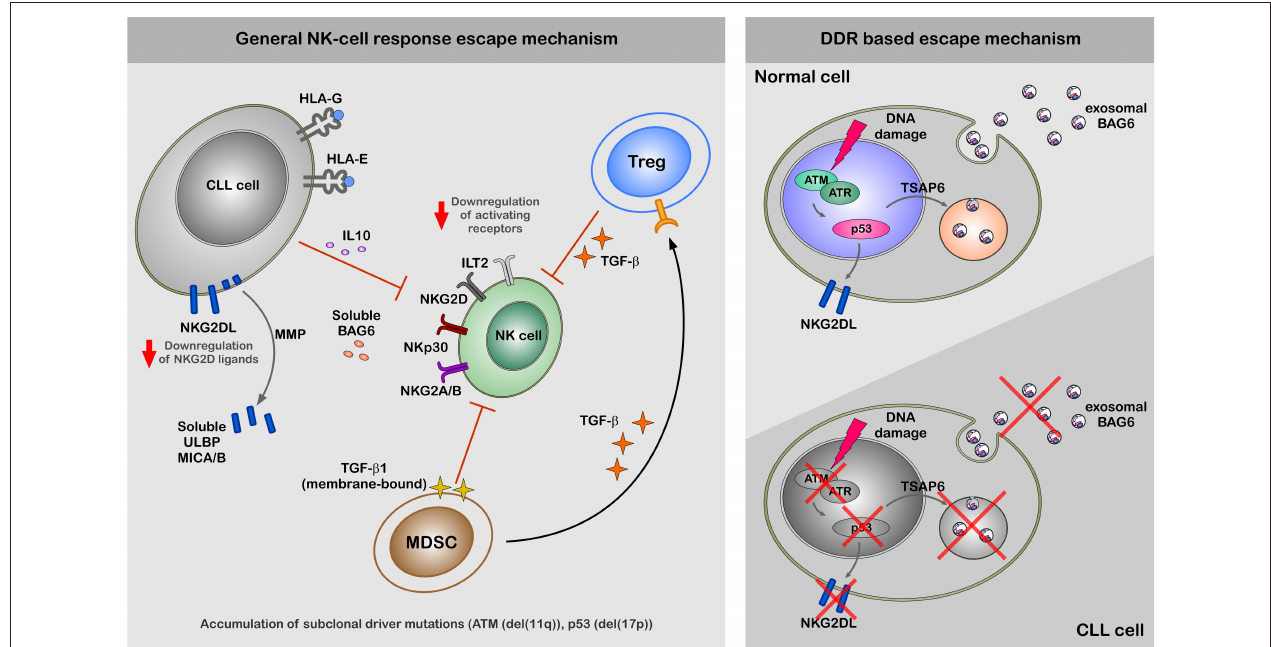
regulated by MDSC and Treg cells via production of TGF β and IL-10, which modulate expression levels of activating receptors on the cell surface of NK cells. The right panel of the figure is focused on the impaired DDR and its role for the escape from NK-cell response. Induction of DDR in healthy cells results in activation ATM-p53 axis. Activation of p53 results in cell surface expression of NKG2D ligands and exosomal release of BAG6 following transcriptional activation of TSAP6. Cell surface expression of NKG2D ligands and exosomal expression of BAG6 is impaired in CLL cells due to defects in